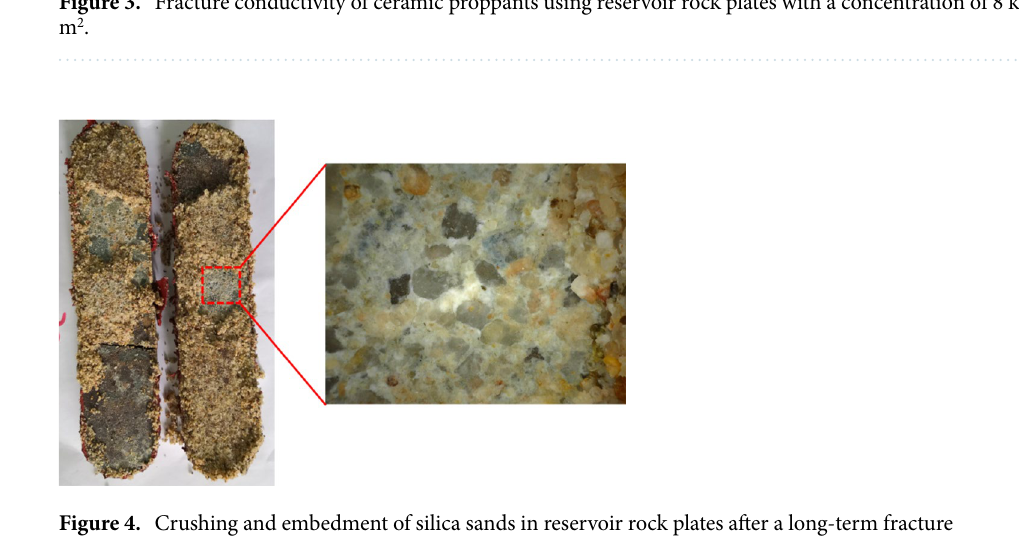
Figure 4. Crushing and embedment of silica sands in reservoir rock plates after a long-term fracture conductivity